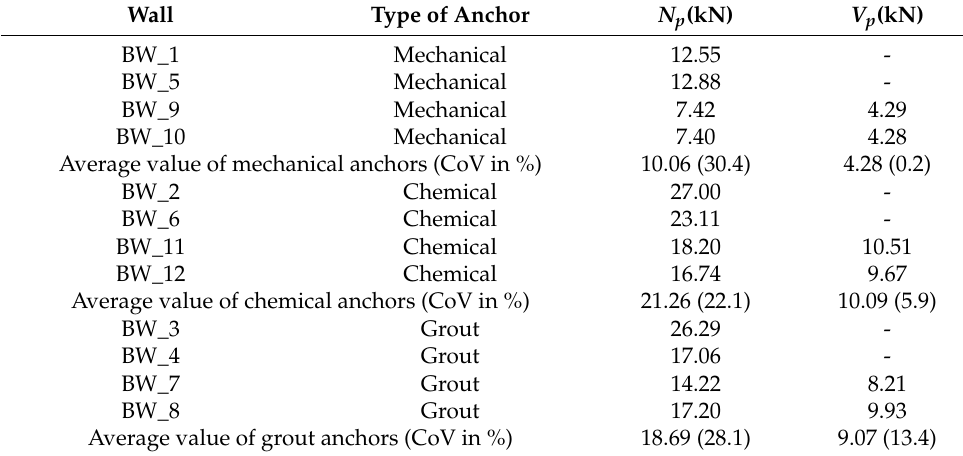
Table 8. Summary of N p and V p values obtained from the pull-out